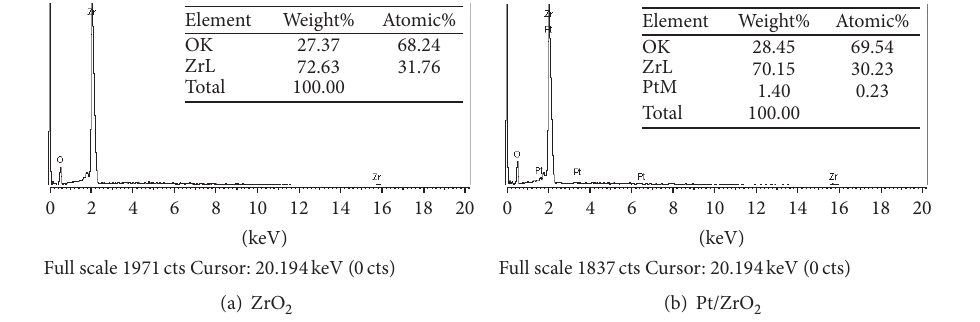
Figure 2: EDX spectra of the (a) pure ZrO 2 and (b) platinum supported on zirconia.